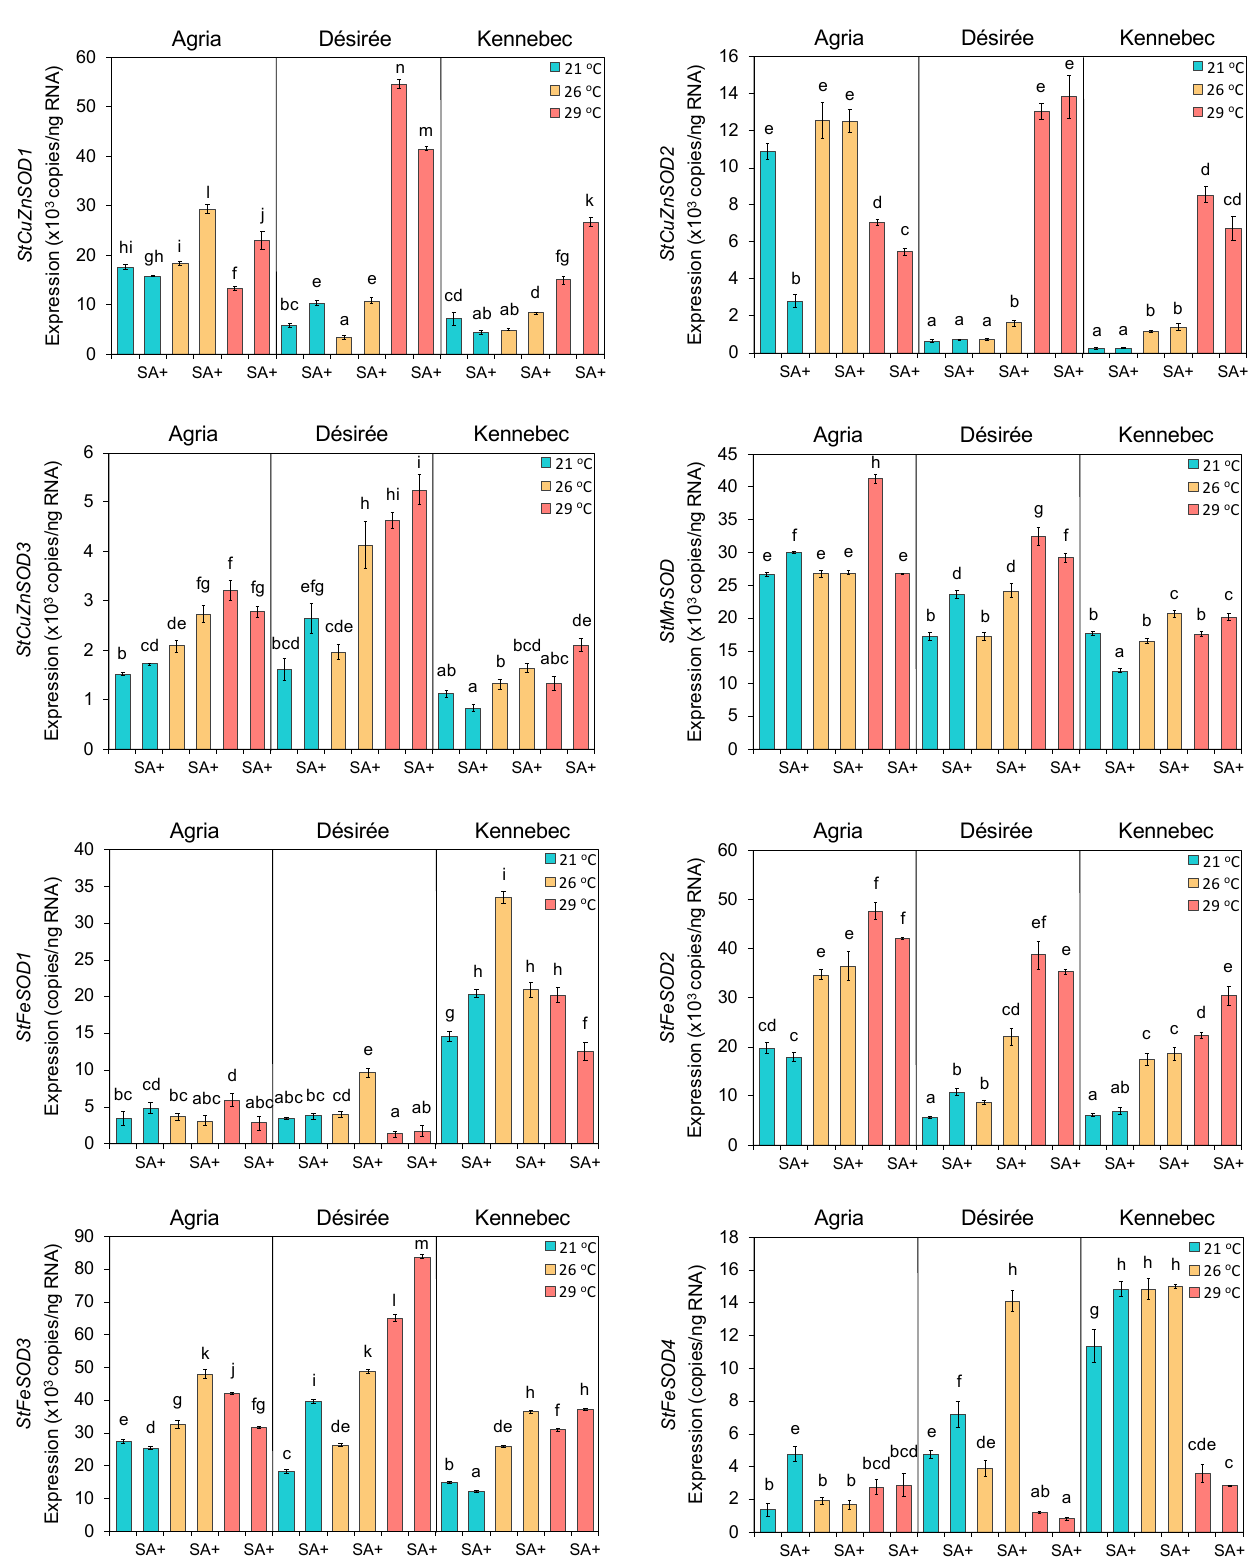
Figure 7. Expression profiles of potato StSOD genes under different temperature conditions and exogenous SA application. Real-time PCR was used both to validate the presence of